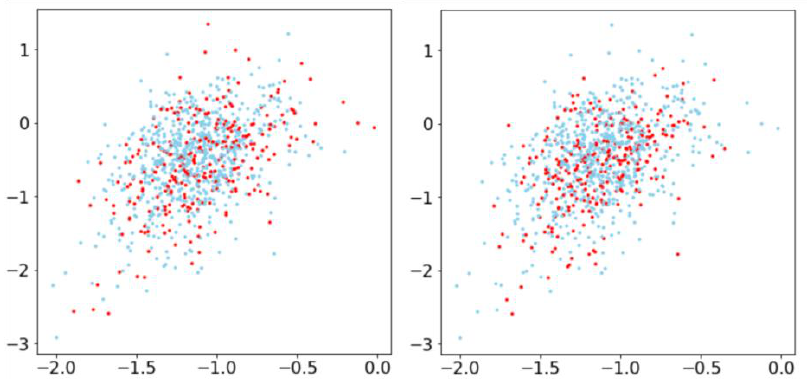
Figure 6. MovieLens 100K demographic information. The left graph shows the latent embedding location of female (red) versus male (blue) users, whereas the right graph shows over 40 years old users (red) versus younger users (blue).